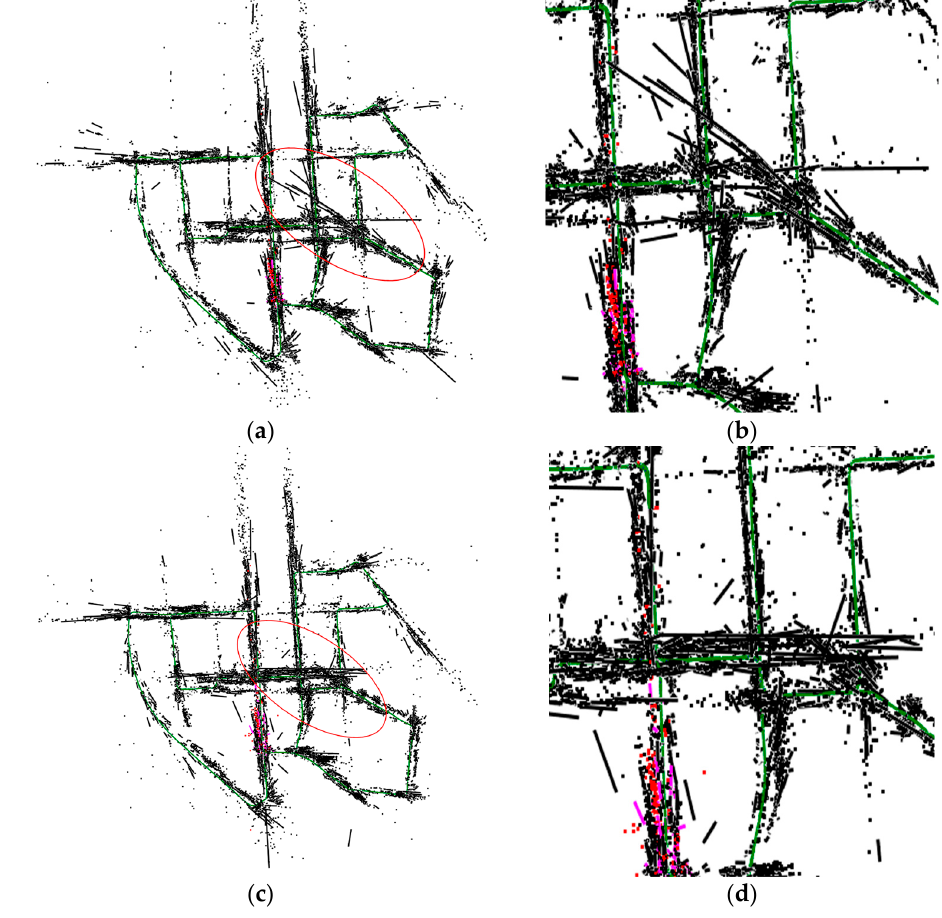
Figure 5. Comparison of point-line graphs before and after geometric constraints, where the green line is the camera movement trajectory, the black dot line is the point-line graph, the red point is the point feature seen by the SLAM system from the current perspective, and the pink line is the current perspective of the SLAM system line features. ( a , b ) show the global and local point-line feature maps, respectively, before applying geometric constraints, while ( c , d ) show the global and local point-line feature maps, respectively, after applying geometric constraints. The local point-line feature map and trajectory correspond to the red ellipse area in the global map., in which the local point-line feature map and the trajectory corresponding to the red ellipse area in the global map. ( a ) Global point-line map and trajectory. ( b ) Local point-line map and trajectory. ( c ) Global point-line map and trajectory. ( d ) Local point-line map and trajectory.